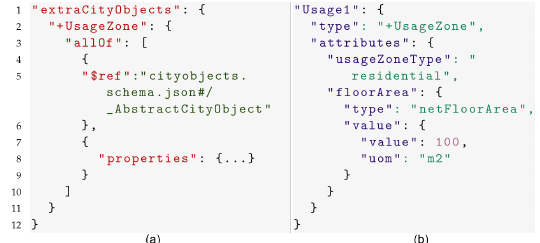
Figure 4. A new CityObject (a) defined in the Extension schema, (b) used in a CityJSON file.